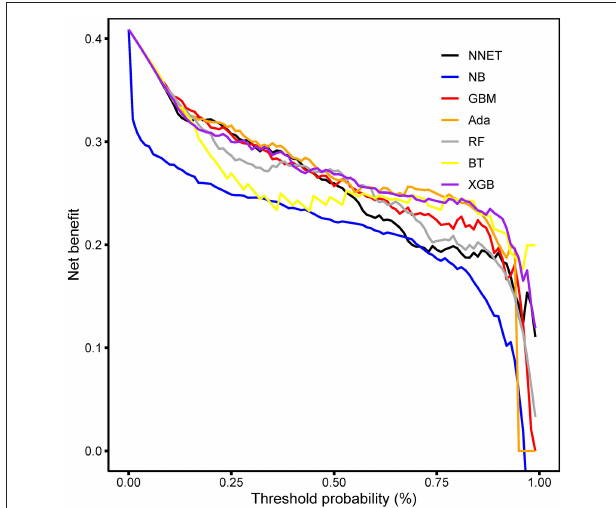
FIGURE 4 | Decision curve analysis. The net benefits of the Ada and XGB are relatively larger over a range of threshold probability values compared with those of other ML models. Ada, adapting boosting; XGB, eXtreme Gradient Boosting; ML, machine learning. NNET, arti?cial neural network; NB, naïve bayes; GBM, gradient boosting machine; RF, random forest; BT, bagged